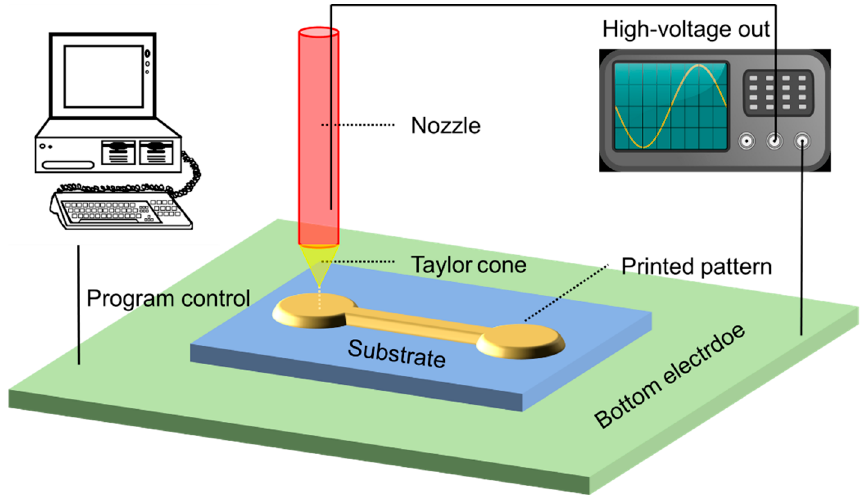
Figure 1. Schematic diagram of electrohydrodynamic (EHD) printing.